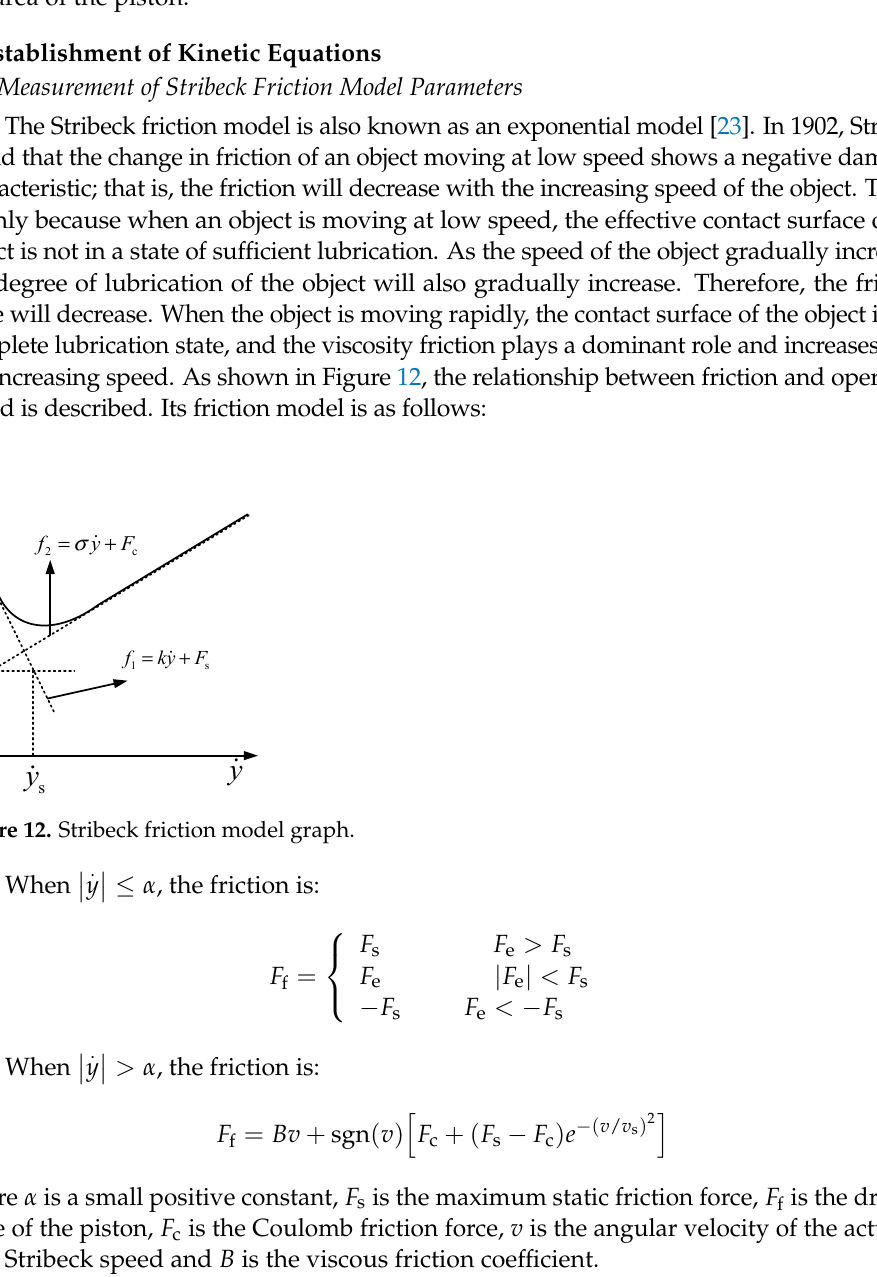
F axis is expressed as f F C